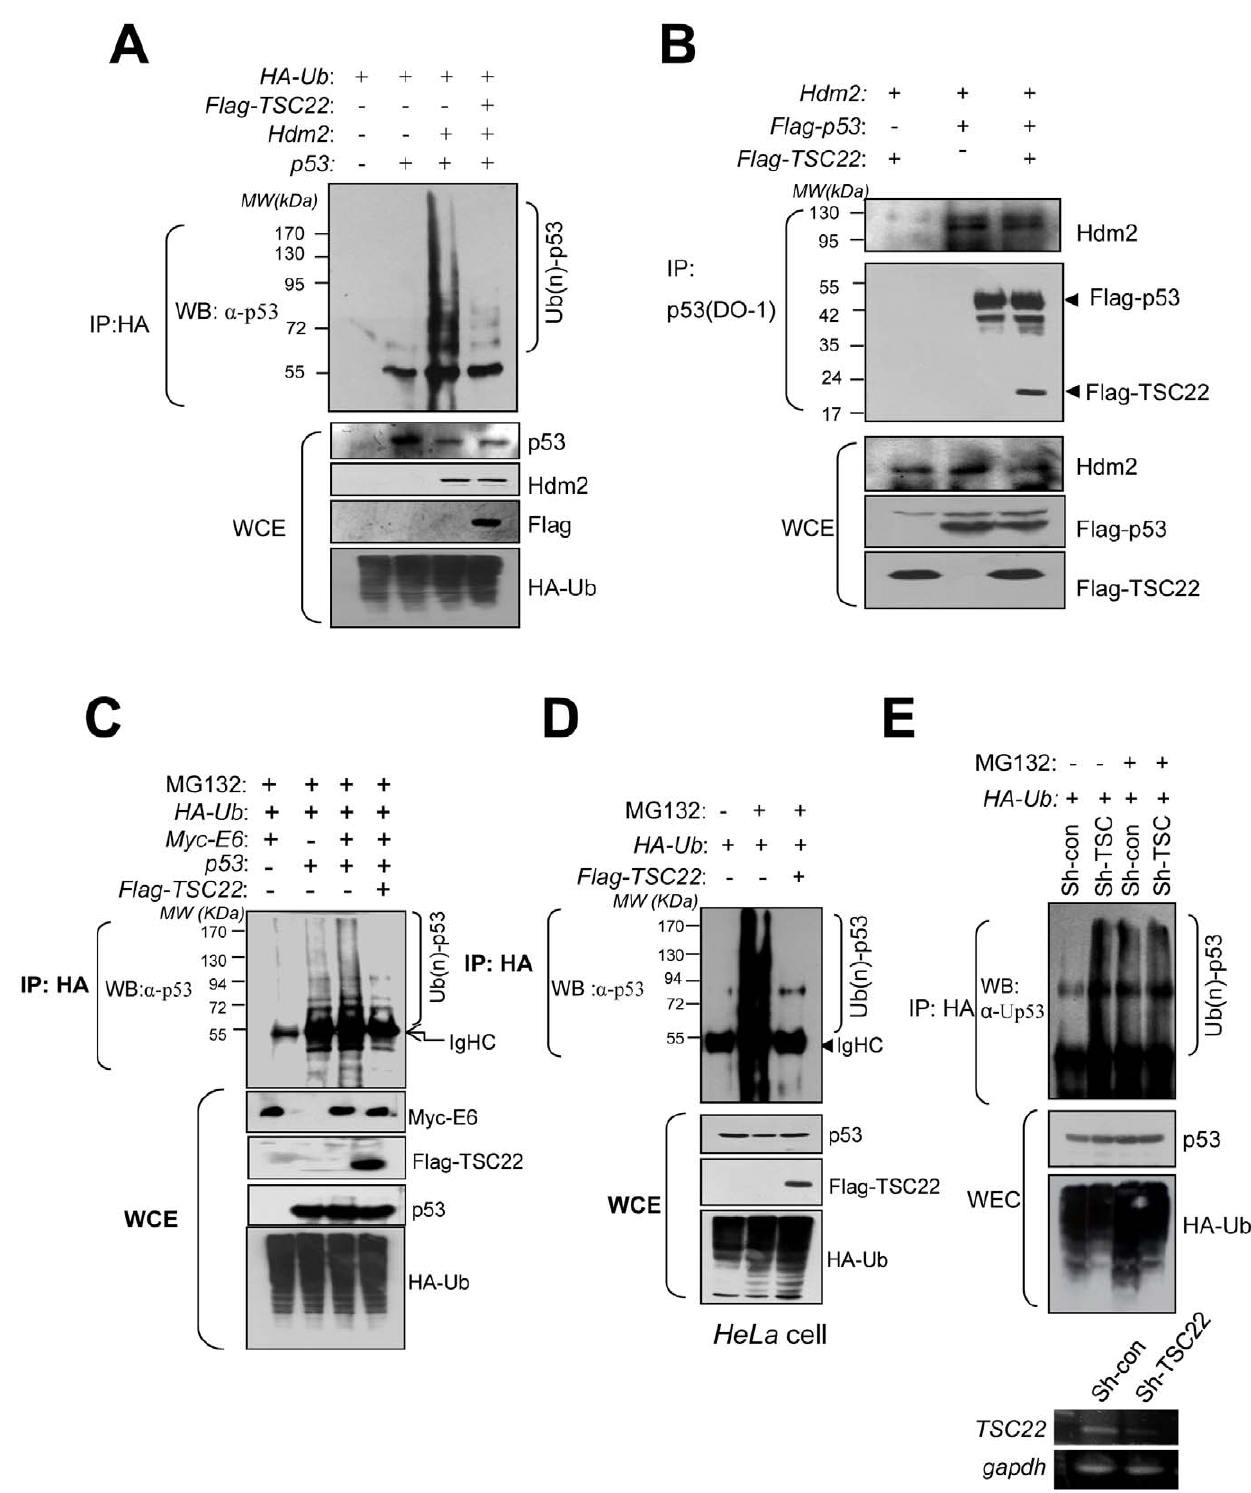
Figure 5. TSC22 inhibits HDM2- and E6-mediated p53 ubiquitination. (A) TSC22 inhibits HDM2-mediated p53 ubiquitination. H1299 cells were transfected with the indicated plasmids. The transfected cells were treated with MG132 (20 m M) for 5 h before harvest. Cell lysates were immunoprecipitated with an anti-HA antibody. Ubiquitinated p53 was detected by Western blotting with an anti-p53 antibody (DO-1). Ubiquitinated p53 is indicated as Ub(n)-p53 (upper panel). The expression of total p53, HDM2, Flag-TSC-22 and HA-Ub proteins are shown in the lower panels. (B) TSC-22 does not interrupt interaction between p53 and HDM2. H1299 cells were transfected with Flag-p53 along with Flag-TSC-22 or a Flag-mock vector in the presence of an HDM2 expression vector. Cell lysates were immunoprecipitated with the anti-p53 (DO-1) antibody followed by Western blotting using the indicated antibodies. Lysate (5%) was analyzed by Western blotting using indicated antibodies (lower panel). (C) TSC-22 inhibits E6-